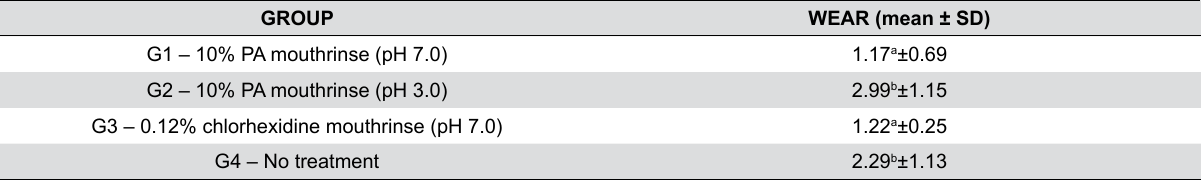
Table 1- Mean (±SD) of dentine wear (μm) of the study groups (n=8